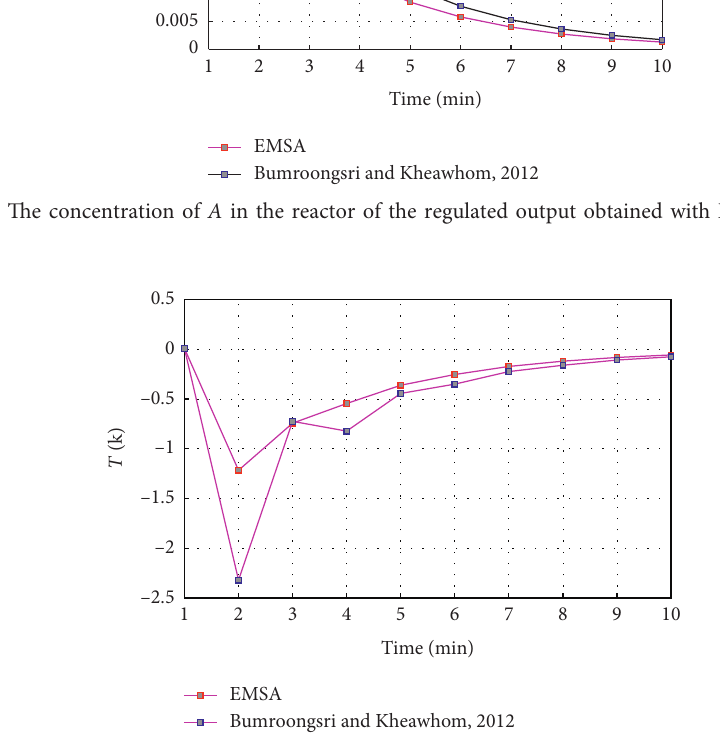
Figure 5: The reactor temperature of the regulated output obtained with EMPS algorithm. Table 2: Performance comparison with previous works.